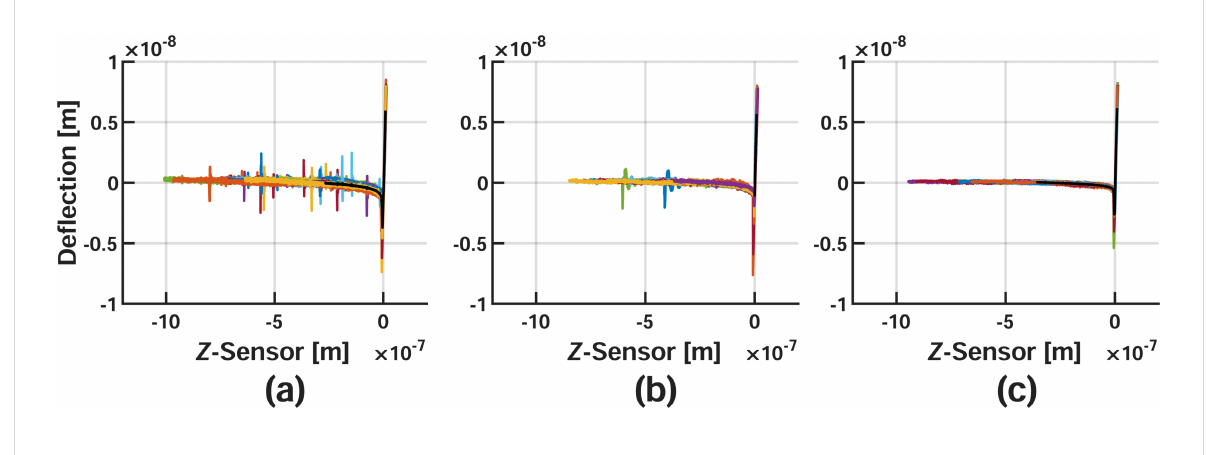
Figure 4: Conditioned AFM-SFS Data for different approach velocities. Corrected nylon data for (a) 10 nm/s, (b) 100 nm/s, and (c) 1000 nm/s. Colored lines represent the various datasets utilized for averaging, and the solid black lines plotted on top show the averaged result.